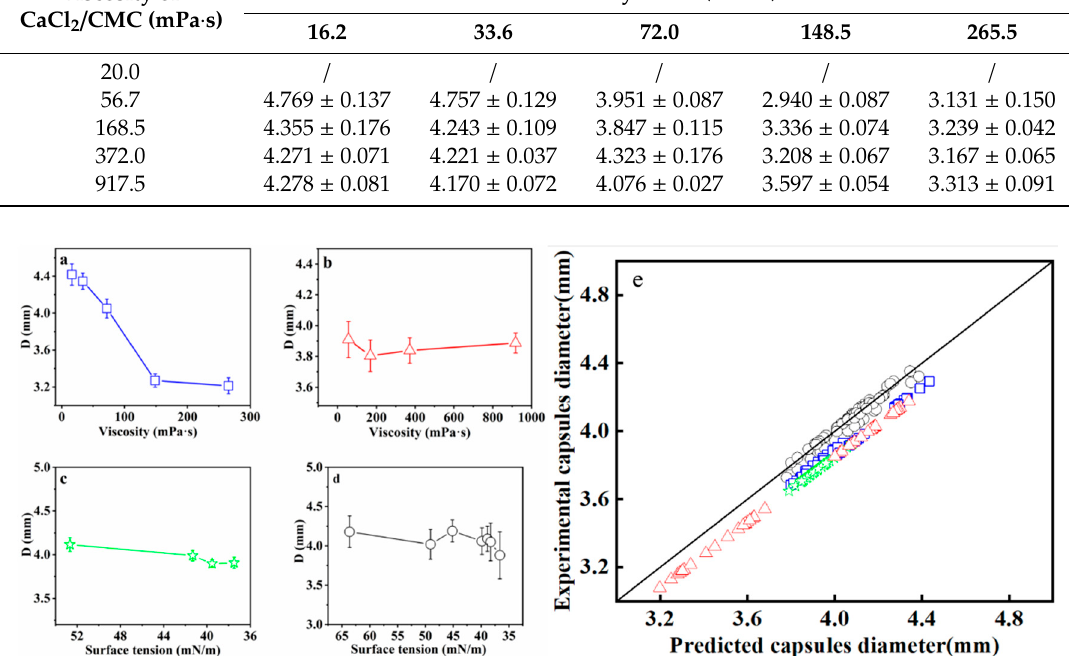
Figure 12. ( a ) Effect of SA solution viscosity on diameter of the mm-CaSA-Caps. The viscosities of the SA solution were 16.2 mPa·s, 33.6 mPa·s, 72.0 mPa·s, 148.5 mPa·s and 265.5 mPa·s when the viscosity